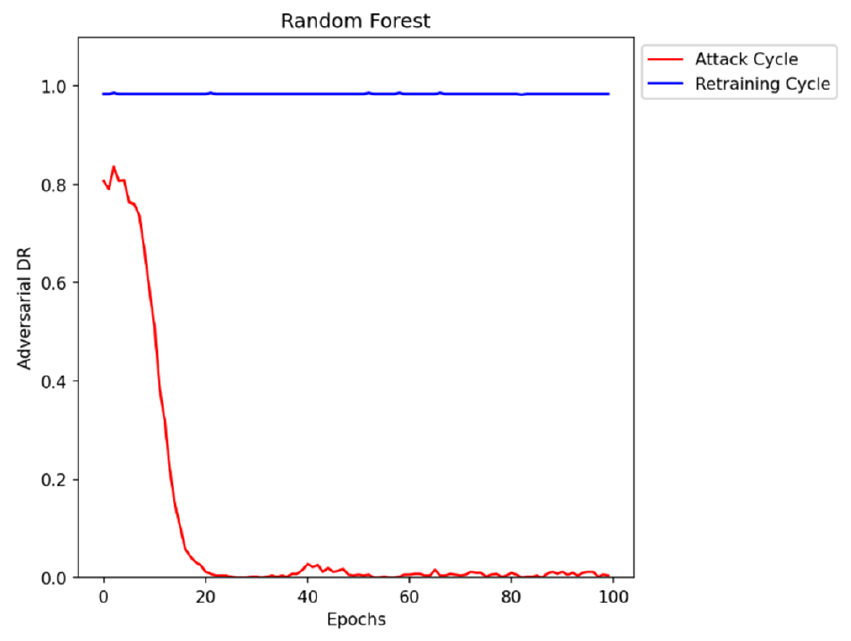
Figure 5. Adversarial DDoS/DoS attack generation and retraining.